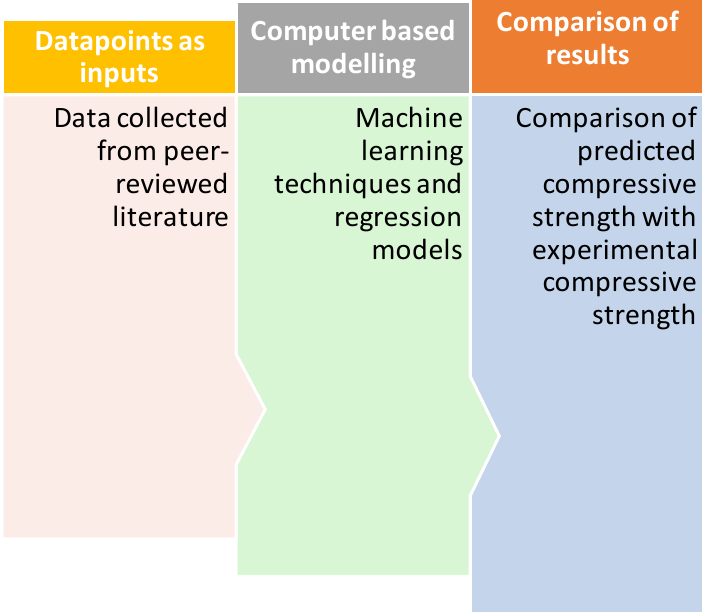
Figure 2. Adopted methodology for study .